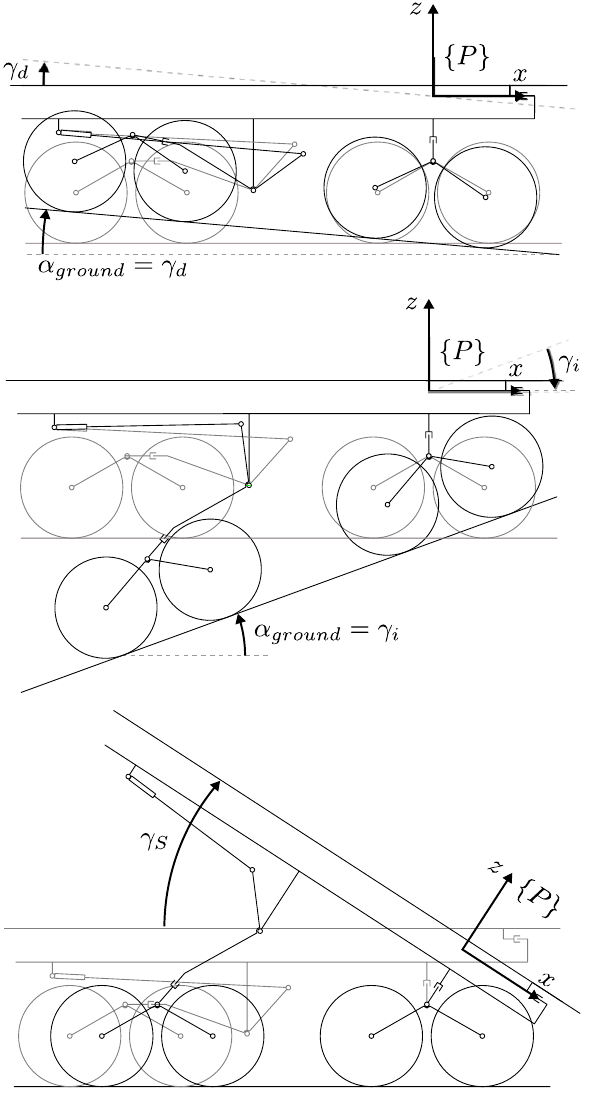
Fig. 3 Functional diagram of Agri.Q PV panel pitch motion in rele- vant poses with respect to the nominal one. Top, a self-levelling PV surface in slight descends. Centre, a self-levelling landing surface in the maximum slope incline. Bottom, the maximum PV panels tilt angle to maximise Sun rays collection